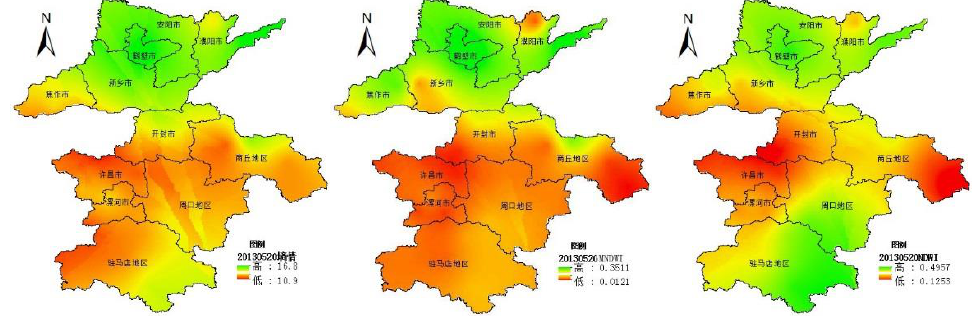
Figure 3 The distribution map of soil moisture, MNDWI, NDWI on March 11, 2012, May 16, 2013 and May 20,